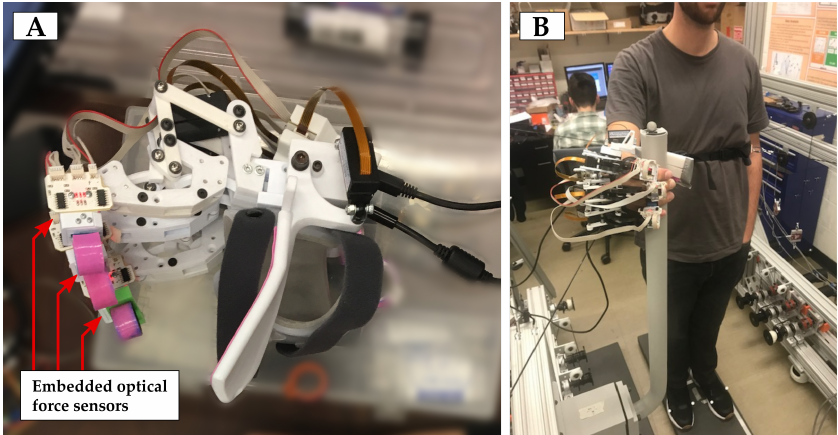
Figure 2. ( A ) Hand exoskeleton used in the experimentation and a detail of the the location of the optical force sensors that are used to measure the interaction force with the hand-rail. ( B ) Subject using the hand exoskeleton to grip the hand-rail in the HR + E